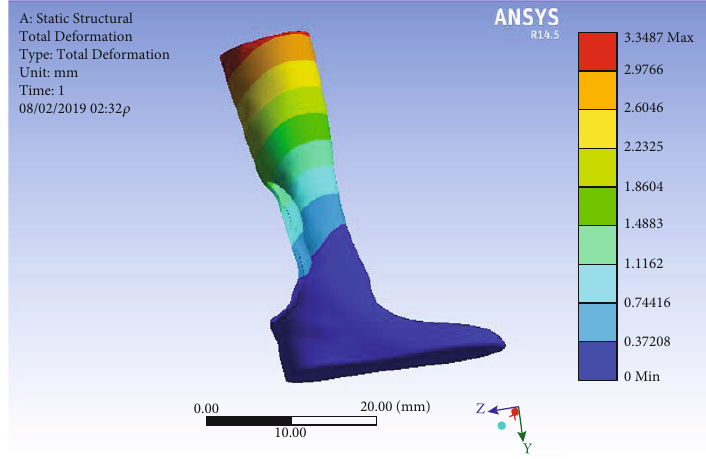
Figure 22: The total deformation in group